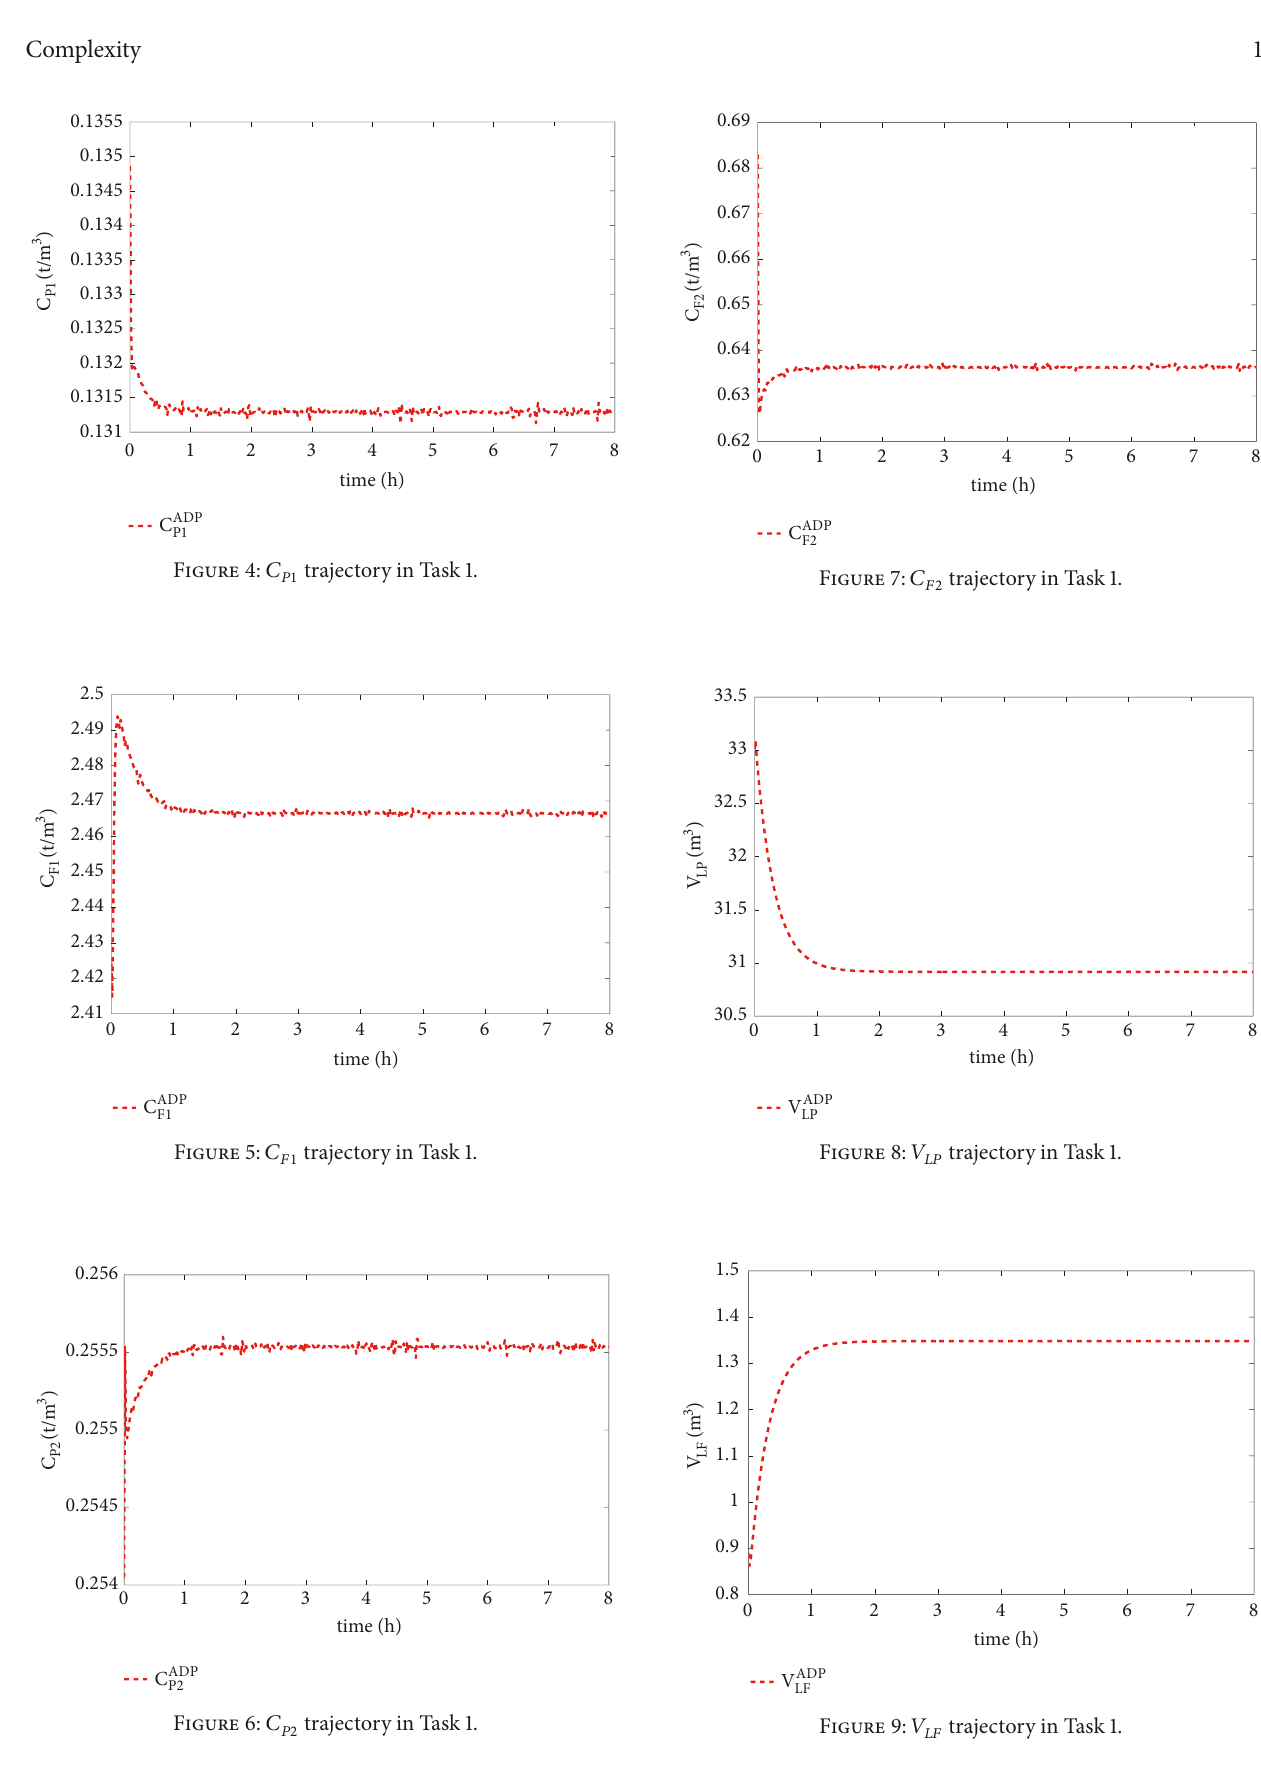
Figure 9: 𝑉 𝐿𝐹 trajectory in Task